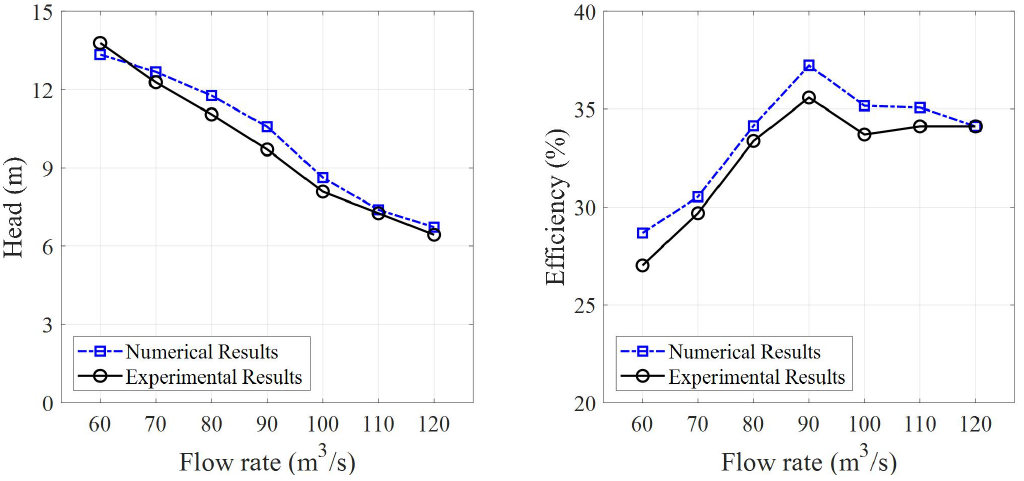
Figure 6. Comparison of experimental and numerical